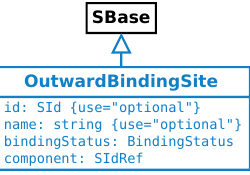
Figure 10: The definition of the OutwardBindingSite